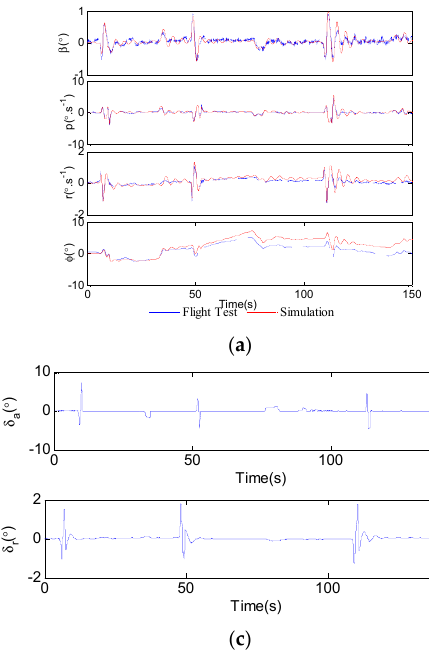
Table 4. GOF of different linearization models of aircraft motion to flight test data.